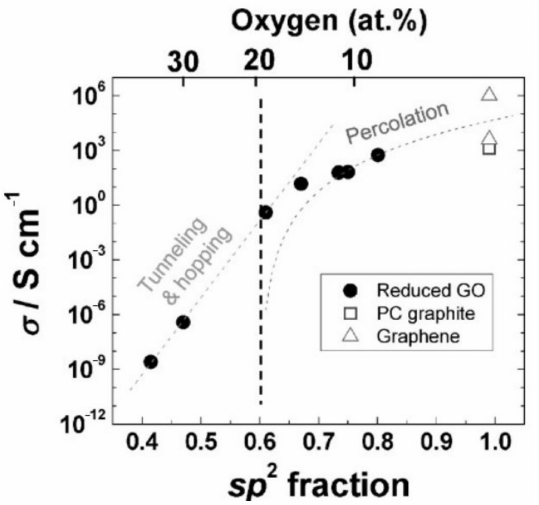
Figure 2. Conductivity of thermally reduced GO as a function of the sp 2 carbon fraction (Reproduced with permission from ref. [37]. Copyright 2009 Wiley